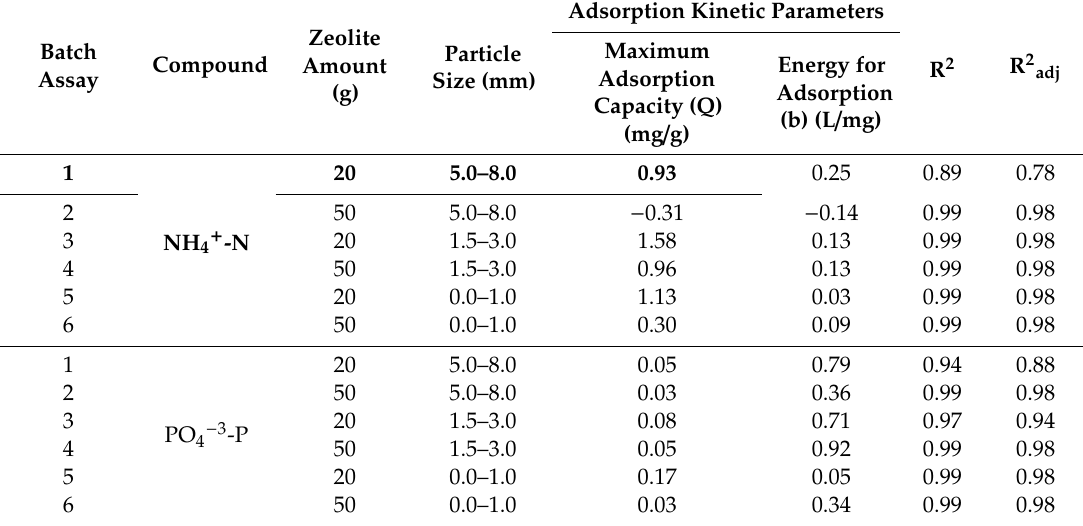
Table 6. Langmuir parameters for NH 4+ -N and PO 43− -P adsorption onto zeolite.